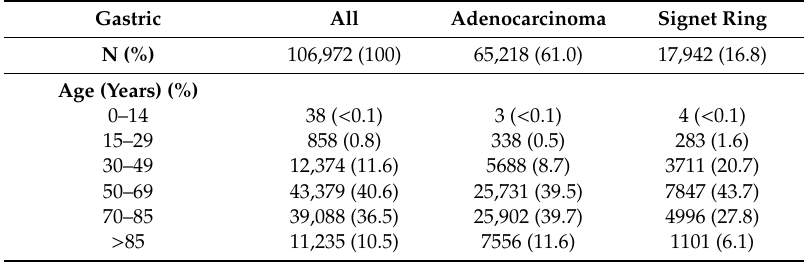
Table 1. Baseline demographics and clinical characteristics by histology for gastric cancers. Gastric All Adenocarcinoma Signet